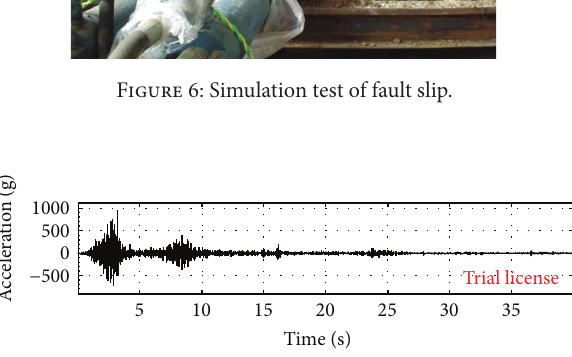
Figure 7: Time history of the Wenchuan-Wolong seismic wave.